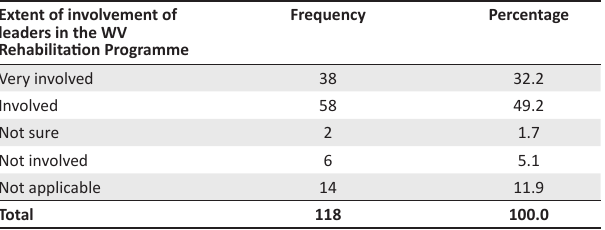
TABLE 2: Involvement of community leaders. Extent of involvement of leaders in the